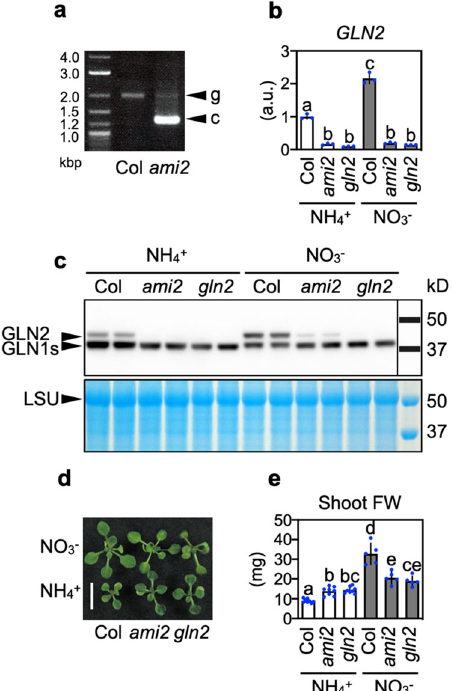
Fig. 2 Downregulation of GLN2 enhances ammonium tolerance. a Genomic PCR using GLN2 -speci fi c primers. g and c denote the